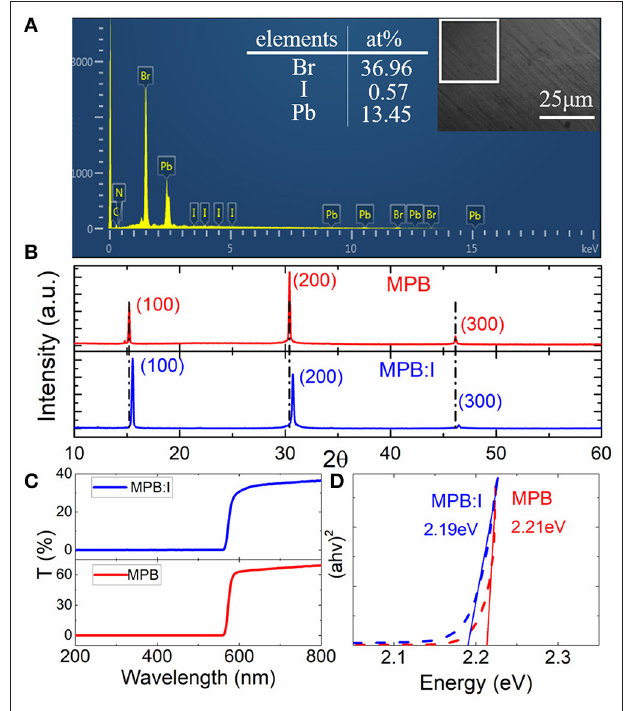
FIGURE 2 | (A) Scanning electron microscopy (SEM) and energy dispersive spectroscopy (EDS) of the MPB:I crystals. The inset picture shows the planar area mapping. (B) X-ray diffraction (XRD) patterns with red line for MPB and blue one for MPB:I single crystals. (C) The UV-VIS-NIR spectrum of MPB:I and MPB single crystals, respectively. (D) The obtained band gap with red line for MPB:I single crystals and blue one for MPB single crystals.